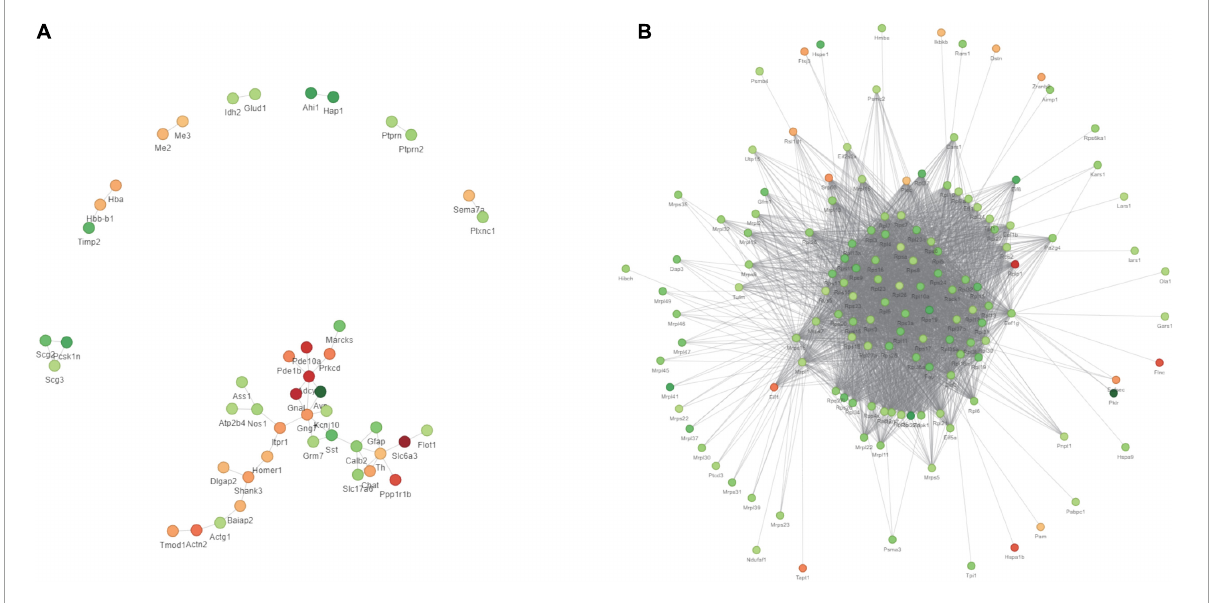
FIGURE9 The results of TMT labeling studies. The PPI network of DEPs between the PD and PWP groups. (A) DEPs in substantia nigra tissues. (B) DEPs in duodenal tissues.